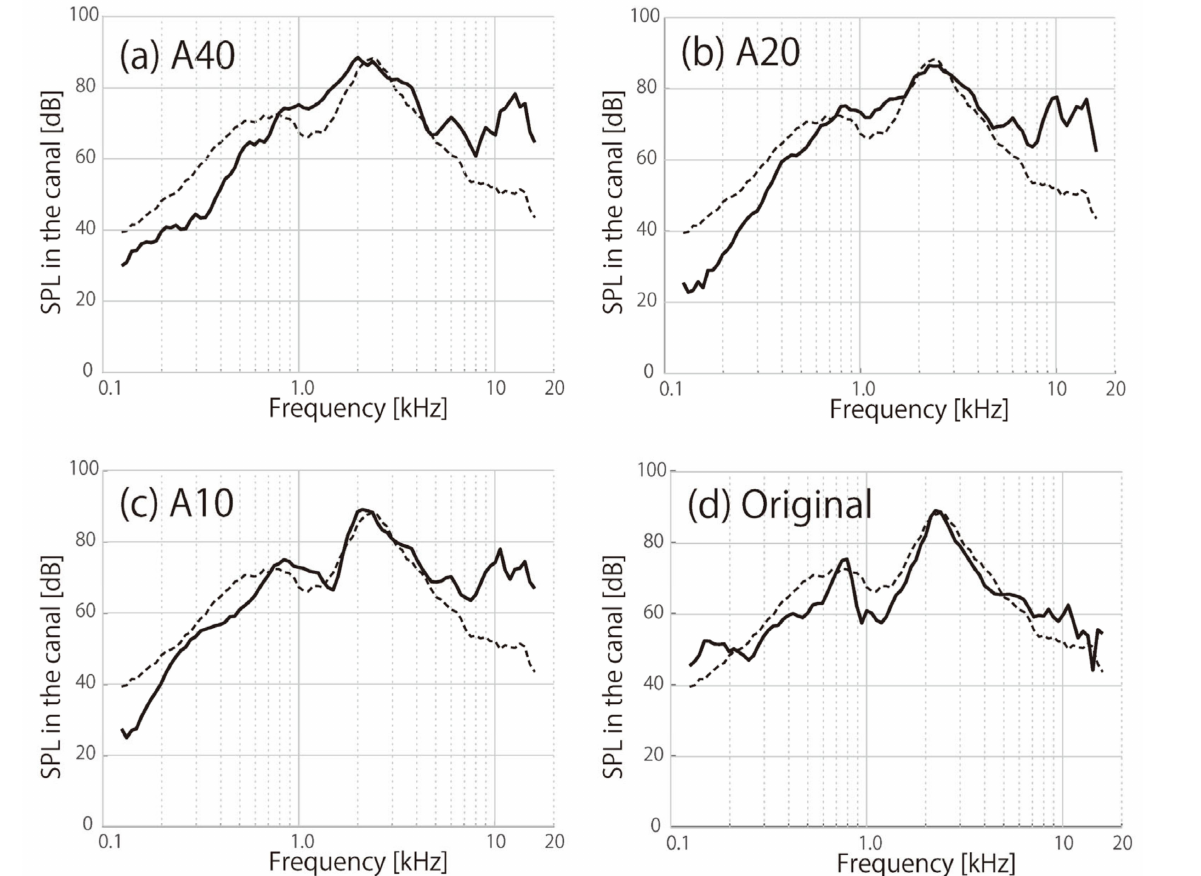
Figure 3. Simulated cartilage-conduction sound obtained by the HATS with different pinna simula- tors: ( a ) A40, ( b ) A20, ( c ) A10, and ( d ) original silicon-rubber-based HATS pinna simulator (solid line). The dashed lines indicate the measured cartilage-conduction sound obtained from the participants. The spectral shapes of A10 and A20 became more similar to those obtained from the